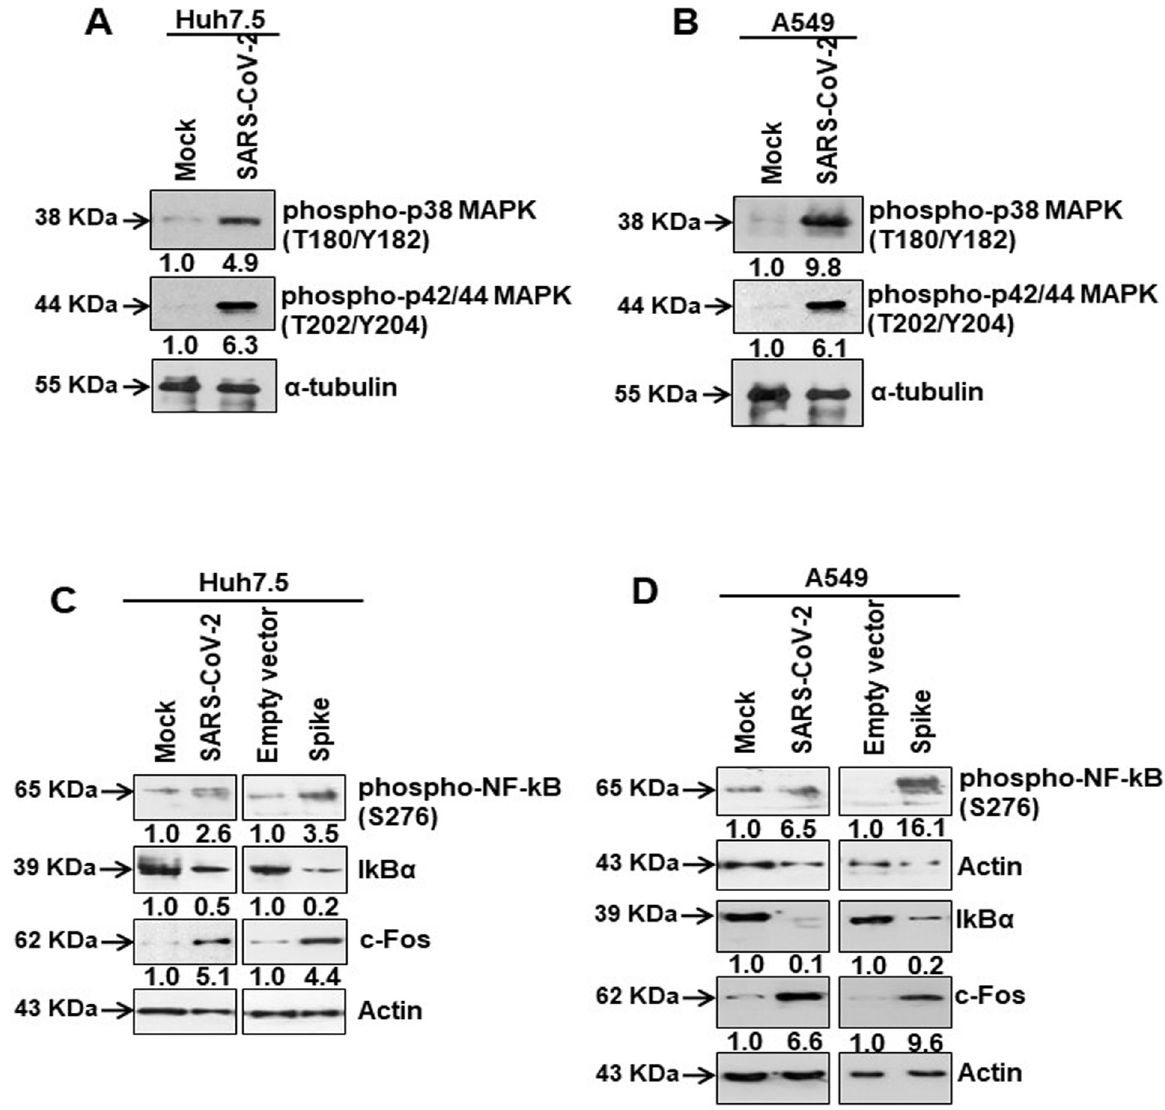
Fig 2. SARS-CoV-2 spike protein activates the transcription factors for IL-6 synthesis. (A, B) Western blot analysis of phospho-p38 MAPK (Thr180/Tyr182) and phospho-p42/44 MAPK (Thr202/Tyr204) in Huh7.5 and A649 cell lysates prepared after 48 h of mock- or SARS-CoV-2 virus infection, or transiently transfected with empty vector or SARS-CoV-2 spike gene construct. (C, D) Western blot analysis of phospho-NF- κ B (Ser276), I κ B α and c-Fos expression in Huh7.5 and A549 cell lysates prepared after 48 h of mock- or SARS-CoV-2 virus infection, or transiently transfected with empty vector or SARS-CoV-2 spike gene construct. Expression level of actin or tubulin in each lane from the same gel is shown as a total protein load for comparison.